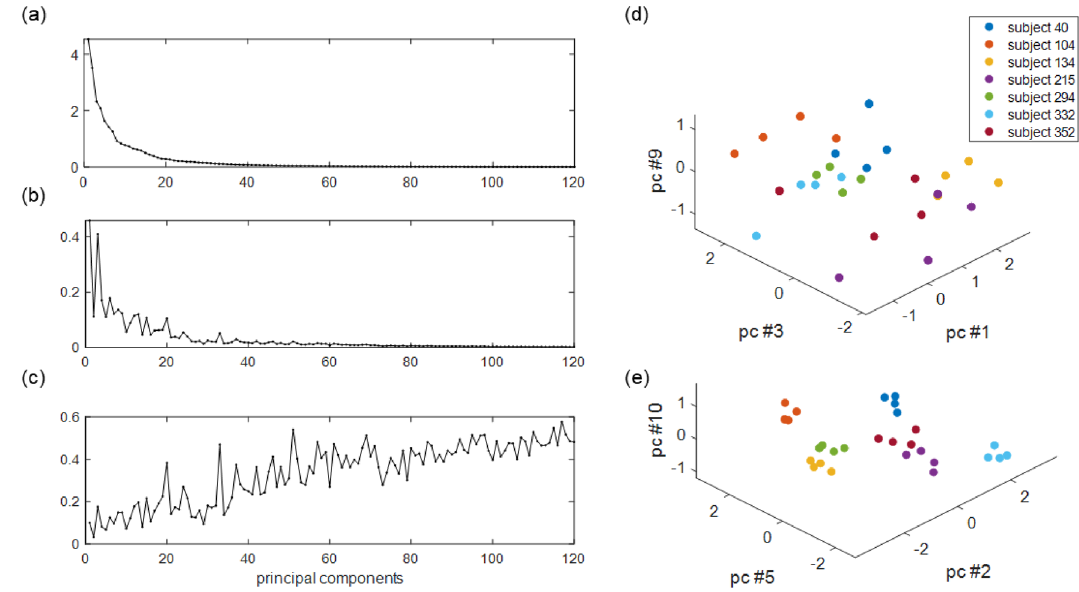
Figure 4. (a–c) Plot of variance properties of 120 principal components. (a) Plot of the explained variance. (b) Plot of the intra-subject variance. (c) Plot of the intra-subject variance to the explained variance ratio. (d,e) Data distribution with example set of principal components.